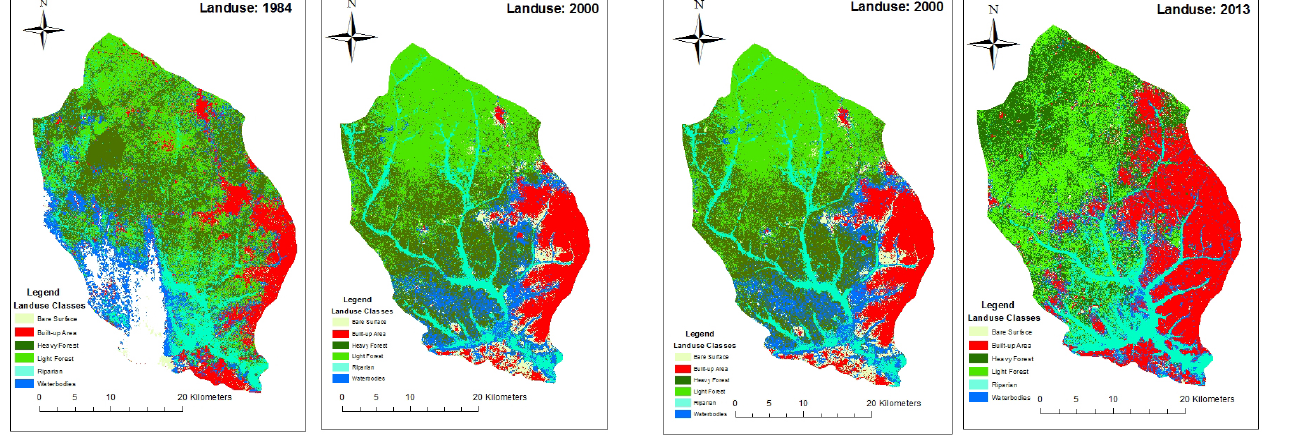
Figure 4. Landuse dynamics of Owo River Basin between 1984 and 2000. Figure 5. Landuse dynamics of Owo River Basin between 2000